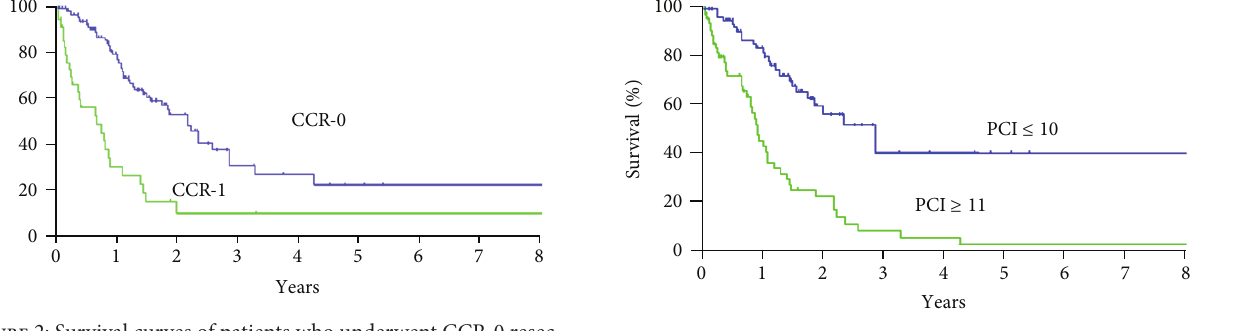
Figure 4: Survival curves of patients with PCI ≤ 10 and those with PCI ≥ 11. MST and 5-year survival rate in patients with PCI ≤ 10 were 33.7 months and 40.0%, but those in patients with PCI ≥ 11 were 10.5 months and 2.9%, respectively.